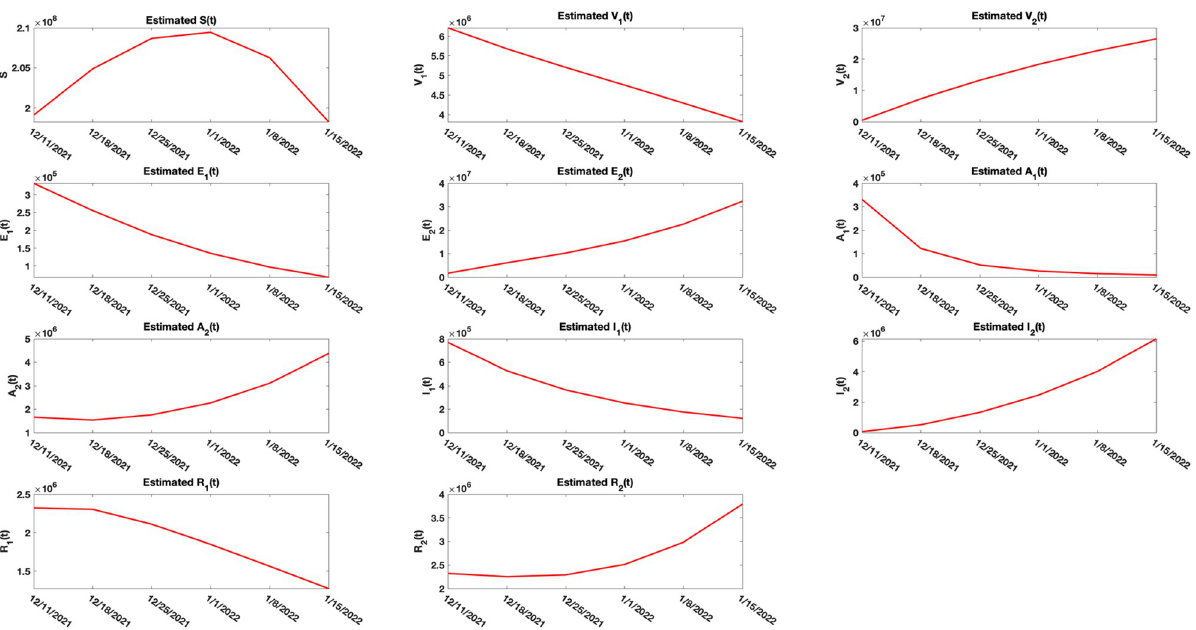
Fig 14. Estimated results for the Delta and Omicron variants. The result shows that the number of Delta exposure and infection cases is decreasing (slowing down) while the number of Omicron exposure and infection cases is increasing (speeding up) between December 11, 2021 and January 15, 2022. These bring about a decrease in the population of those who are vaccinated against the Delta variant and an increase (at a slowing pace) in the number of those vaccinated against the Omicron variant. The number of those susceptible to the variants rises between the period 12.11.2021 to 01.01.2022, after which it started falling until 01.15.2022. The population of those who recovered from the Delta variant is speedingly descreasing while the count of those who recovered from Omicron variant is increasing at a speeding pace. The result of the trajectory of the estimated Delta and Omicron cases is similar to the plot shown in the work of Nyberg et al. [70].